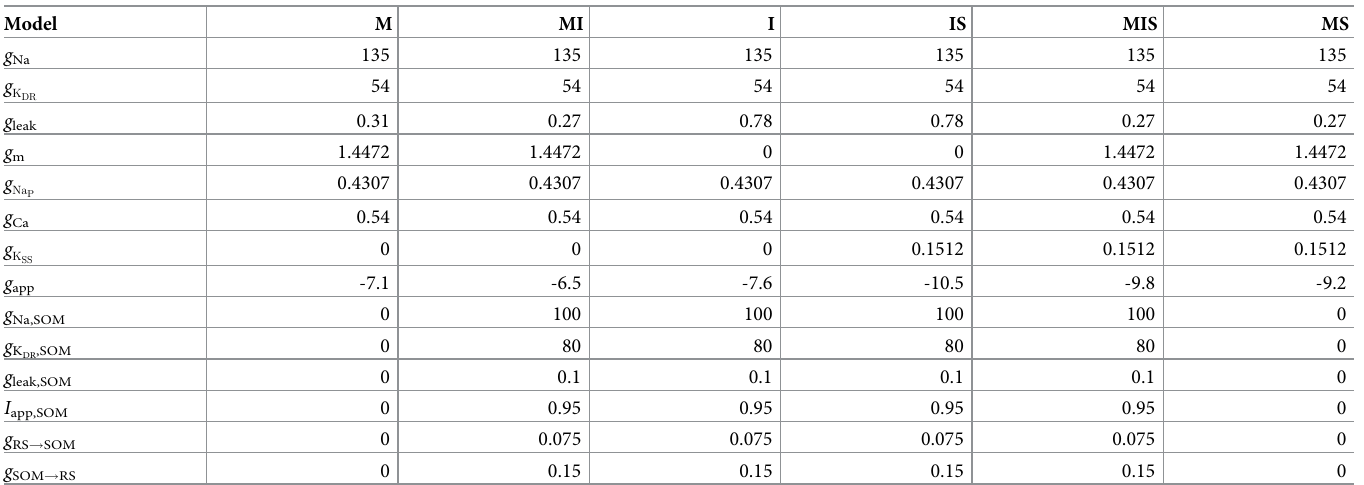
Table 3. Maximal conductances.